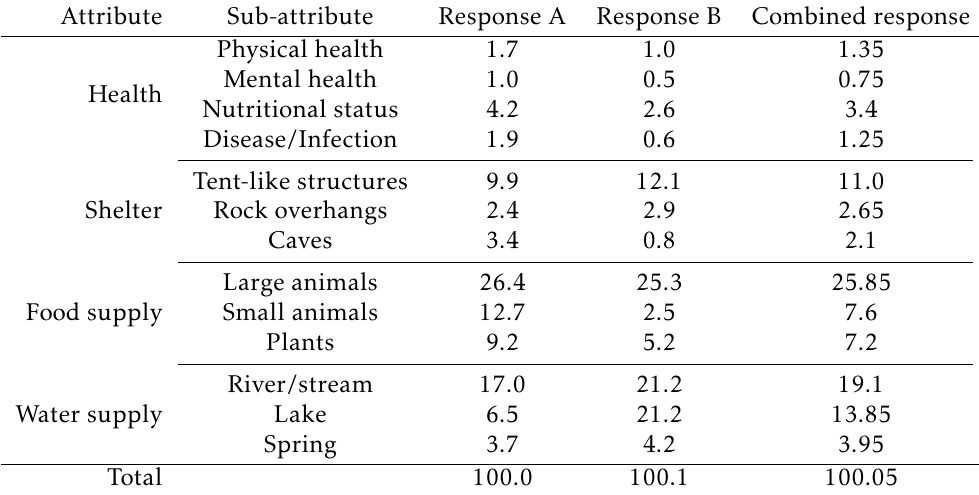
Table 2 – The weights (%) given to each of the 13 resilience sub-attributes by Participants A and B using the BPMSG AHP